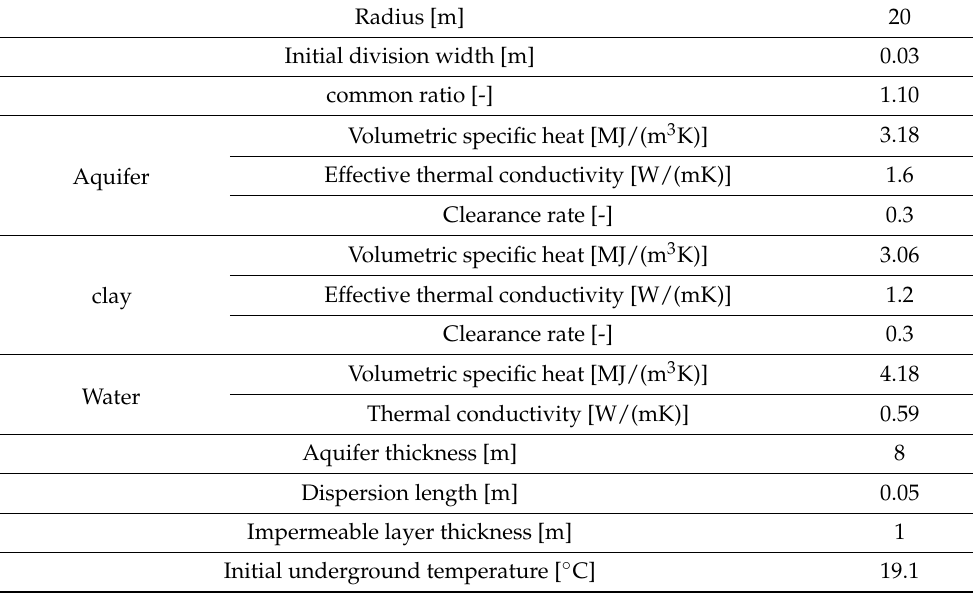
Table A1. The ATES system model input